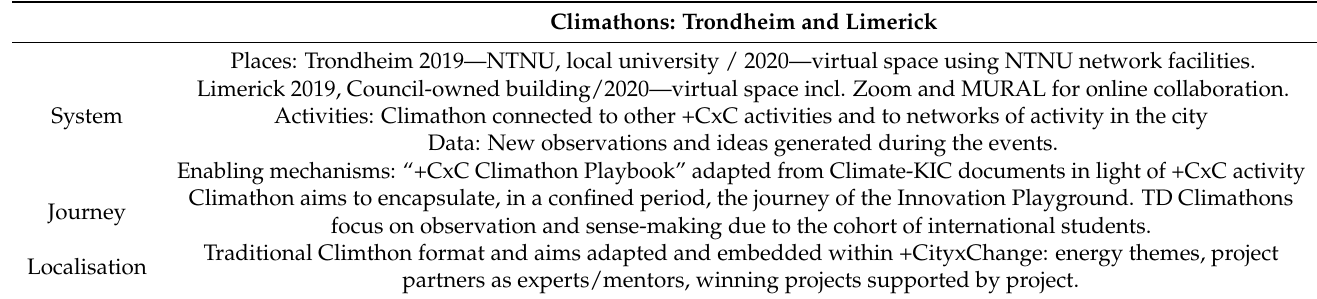
Table 3. Table of Reporting Climathon Events